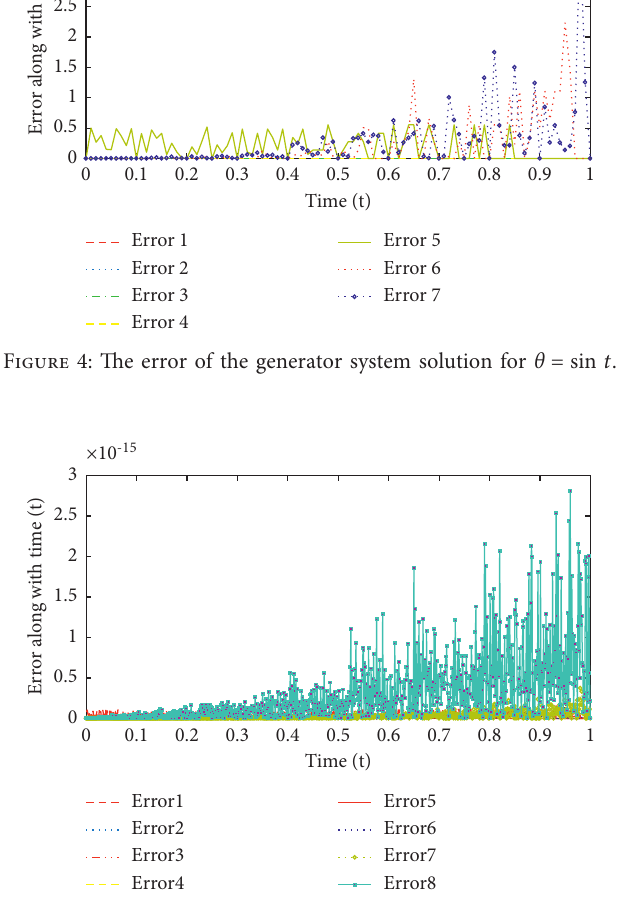
Figure 5: The error of the generator system solution for θ � sin t + cos t